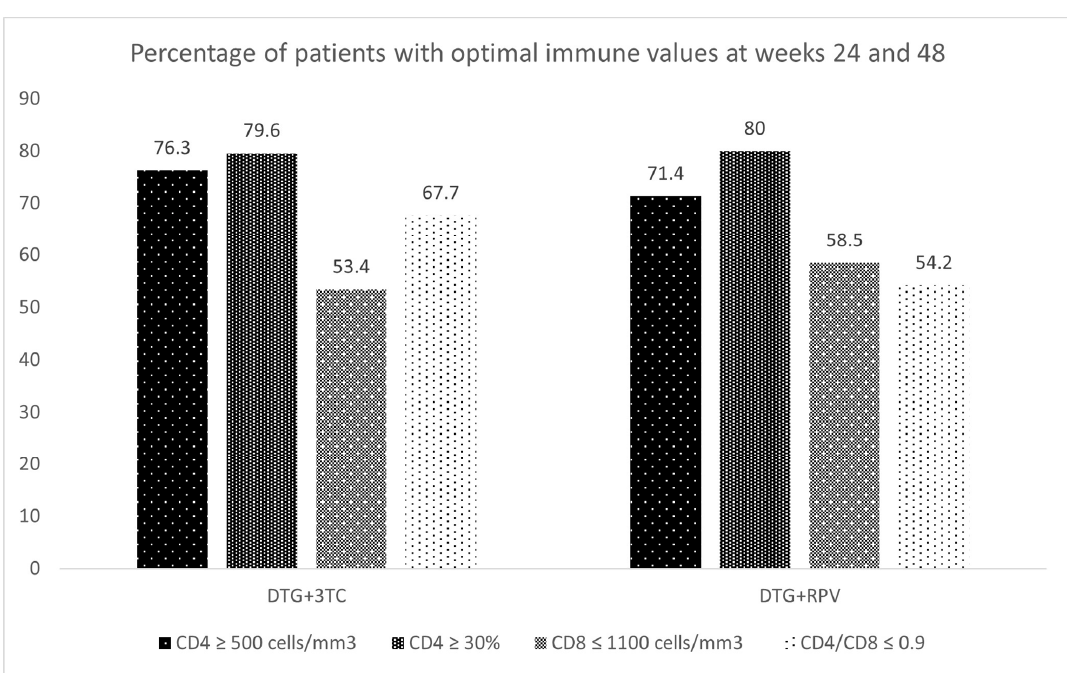
Figure 3. Percentage of patients with optimal immune values at weeks 24 and 48.